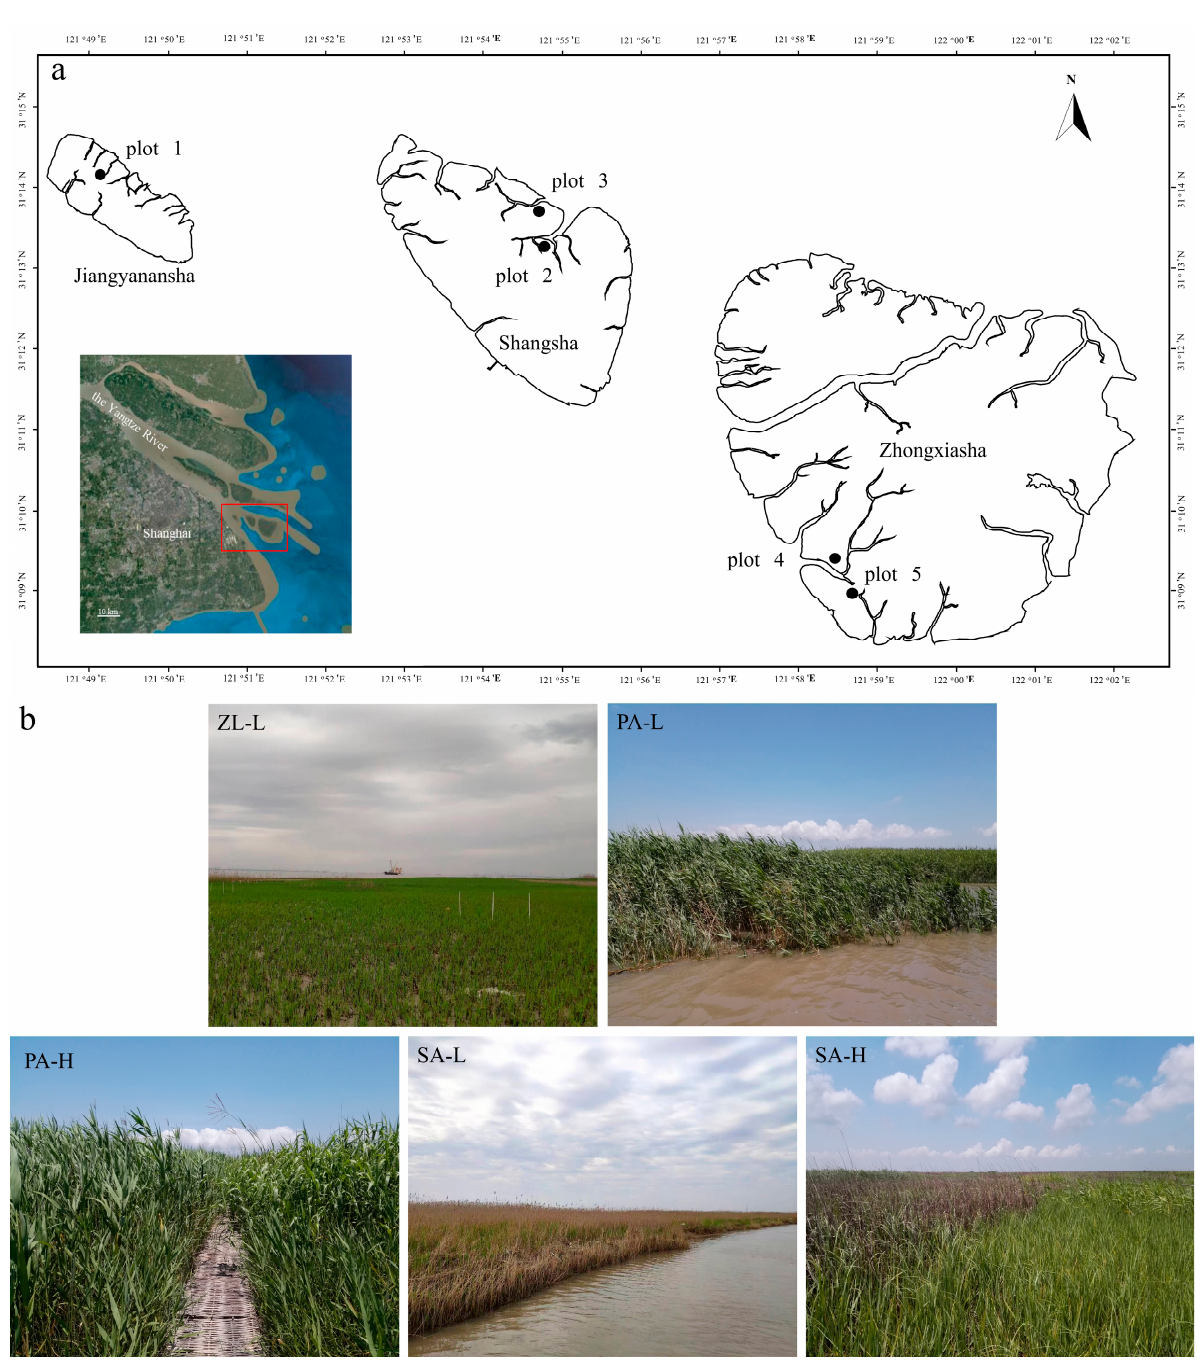
Figure 1. Schematic map of the studied sites in Jiuduansha wetland ( a ) and sample plots ( b ). See Table 1 for codes of the plots. The red frame shows the location of Jiuduansha wetland at the inter- section of the Yangtze River Estuary.